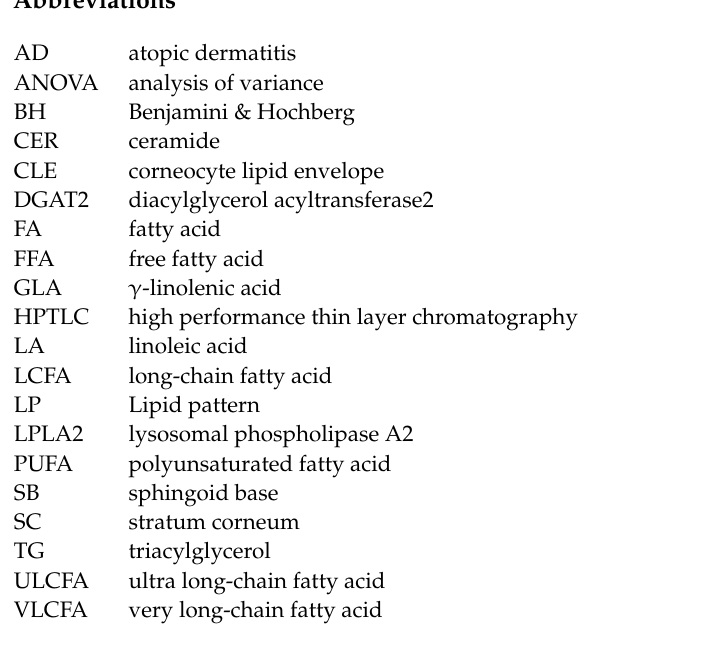
clature; Figure S2: The proportions of skin surface ceramides and triacylglycerols with each chain length or double bond; Figure S3: Total chain length distributions in skin surface ceramide subclasses; Figure S4: Profiles of acylceramides; Figure S5: Spearman correlation heatmap between ceramide subclasses and triacylglycerol species; Figure S6: Spearman correlations between skin health pa- rameters and skin surface lipids; Figure S7: Spearman correlation heatmap between lipid patterns and ceramide and triacylglycerol species; Figure S8: Spearman correlations of lipid patterns with ceramides categorized by amide-linked fatty acid chain lengths; Figure S9: The integrated Spearman correlation network; Table S1: Top10 lipid species according to betweenness